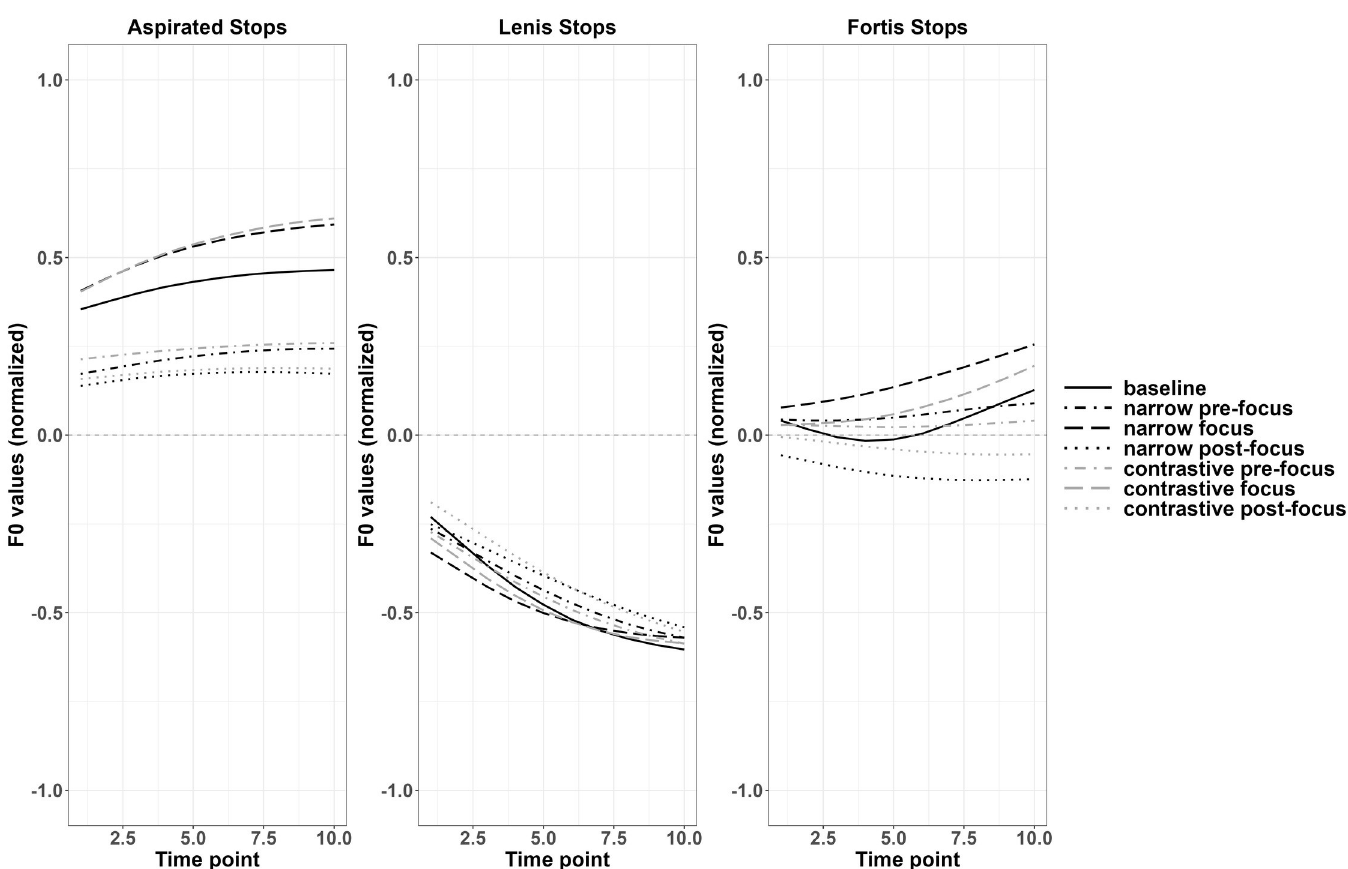
Fig 3. Normalized f0 contours of disyllabic targets in different discourse conditions (Korean).